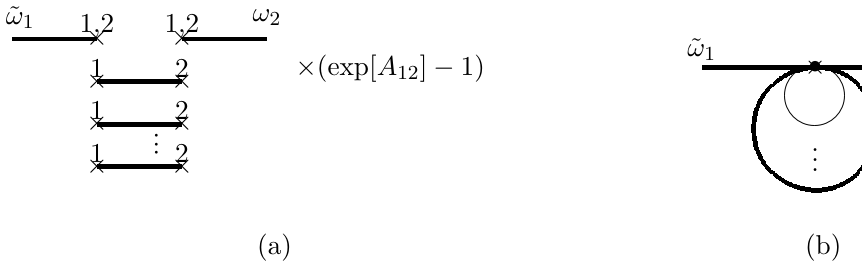
Figure 12 . (a) A set of Feynman diagrams in open closed string field theory that can be part of the leading two instanton contribution to 1 → 1 closed string amplitude. The symbol 1,2 at the × denotes that the vertex may describe either type 1 D-instanton or type 2 D-instanton. (b) The same diagram represented in the closed string effective field theory, with •× representing a two instanton interaction vertex in the closed string effective field theory. As argued in the text, the contribution to these diagrams is suppressed in the small a